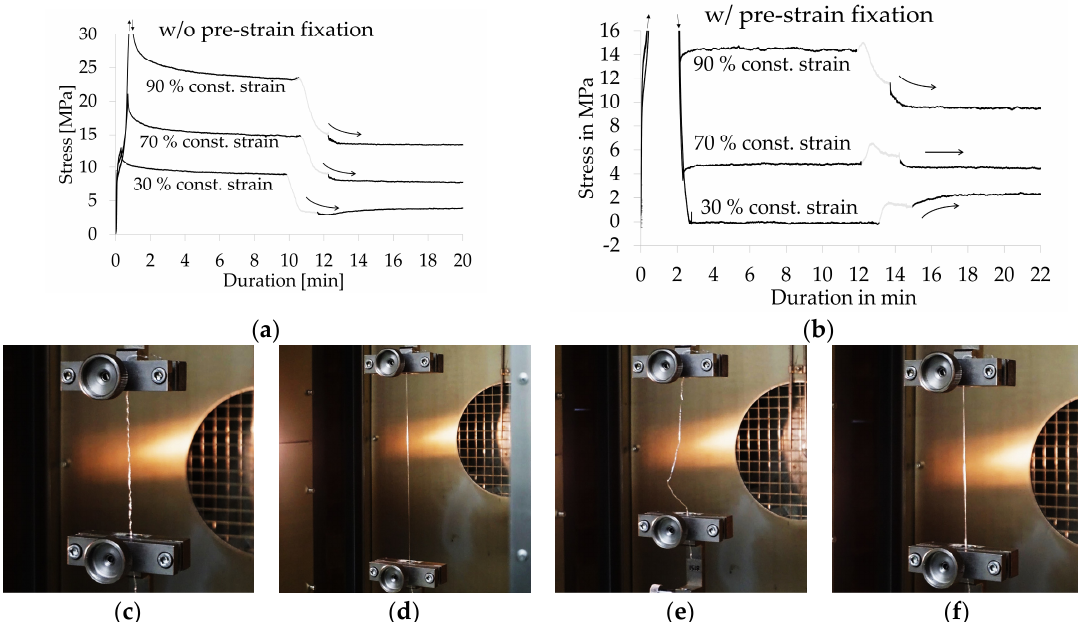
Figure 7. Stress-time-curves of samples w / o ( a ) and w / ( b ) pre-strain fixation, which were kept at a constant strain and subsequently stimulated for the determination of the recovery stress; greyed out curve parts indicate signal distortion due to air flow within heat chamber during heat stimulation; photo series at di ff erent time stages of the experiment of a sample w / pre-strain fixation kept at a constant strain of 30% ( c – f ).